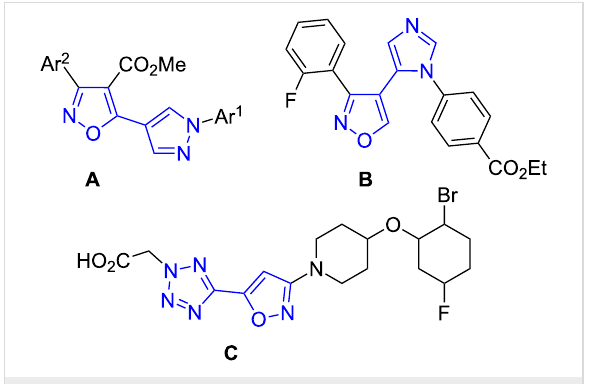
Figure 1: Biologically active isoxazoles conjugated to other azole rings.